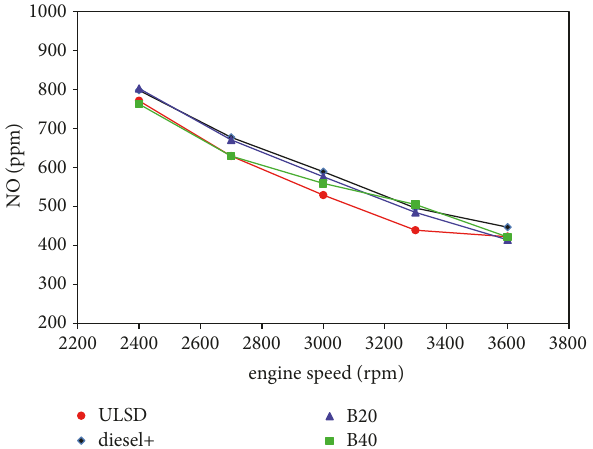
Figure 13: Variation of accumulation mean diameter with engine speed at 80%